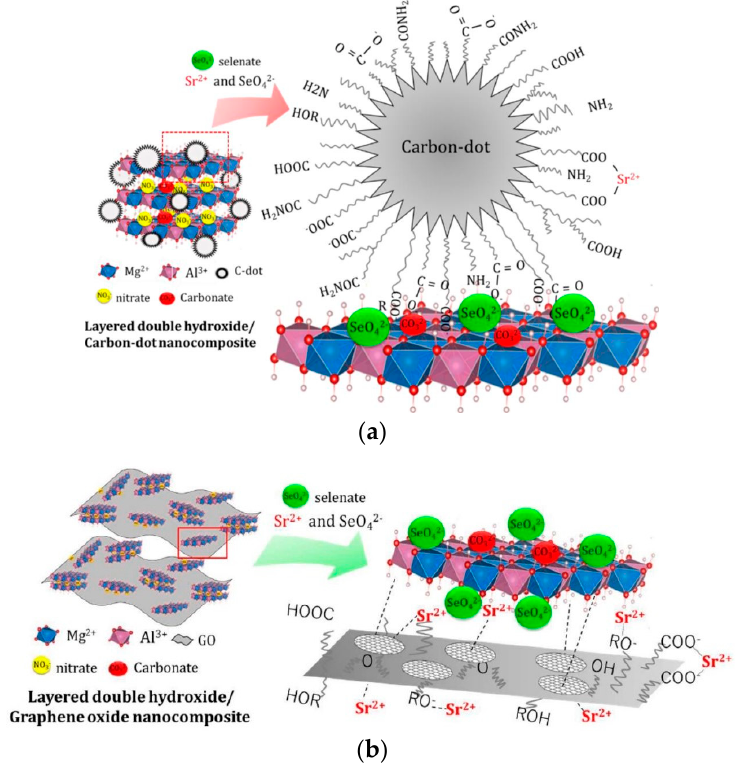
Figure 9. MgAl-NO 3 LDH synthesized by Koilraj et al. and containing: ( a ) carbon nanodots [117]; and ( b ) graphene oxide [118]. Reprinted with permission from references [117,118].